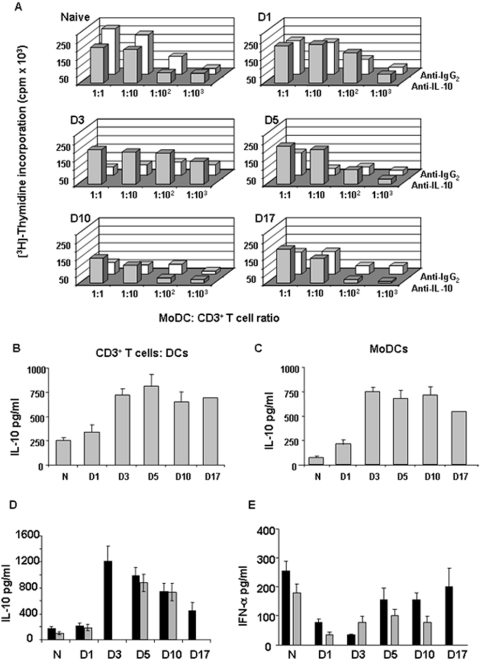
Anti-IL-10 restores T cell activation by MoDCs.A. The allostimulatory capacity of MoDCs from FMDV-infected swine (D1 to D17 pi) and naïve swine is evaluated in the presence of anti-IL-10 monoclonal Ab (gray squares) or an irrelevant antibody (white squares) (see material and Methods). MoDCs were irradiated and used as stimulator cells for allogeneic CD3+ T cells at the T cell/DC ratio indicated. Proliferation was measured in cpm after [3H]Thymidine incorporation. Data is representative of three independent experiments. B. IL-10 production by co-cultures of MoDC from FMDV-infected swine and T cells from a naïve pig. 72 h after the onset of the co-culture (MoDC: CD3+ T cell ratio of 1∶10), supernatants were collected and analyzed for IL-10 production by quantitative ELISA. The figure shows mean concentration values (pg/ml). C. IL-10 production by MoDCs from FMDV-infected swine. IL-10 production by cultures of MoDCs was determined by quantitative ELISA. It is expressed in pg/ml±SD. D. IL-10 produced in sera from FMDV-infected swine at different times post-inoculation. IL-10 was detected by ELISA. Each bar corresponds to one animal and it is expressed as pg/ml±SD. E. IFN-α produced in sera from FMDV-infected swine at days 1, 3, 5, 10 and 17 post-inoculation by ELISA. N, indicates naïve animals. Each bar corresponds to one animal and it is expressed as pg/ml±SD.